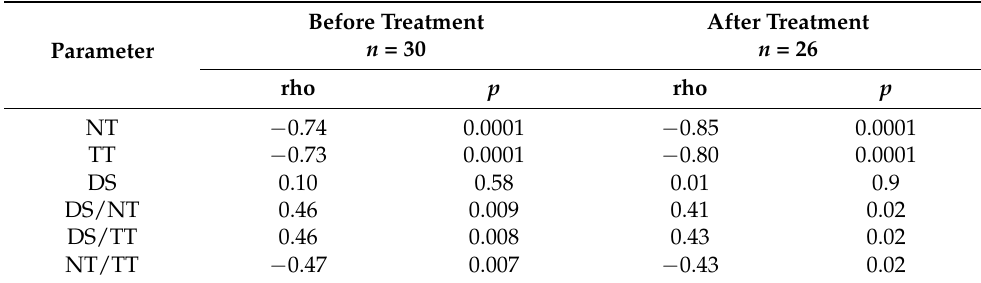
Table 2. Correlations between UAS and TDHPs in patients with chronic spontaneous urticaria, before and after